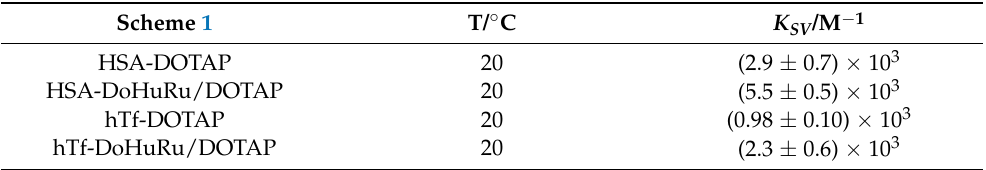
Table 3. Stern–Volmer constants for the complex formation between DOTAP and DoHuRu/DOTAP vesicles with serum proteins (HSA and hTf) obtained at 20 ◦